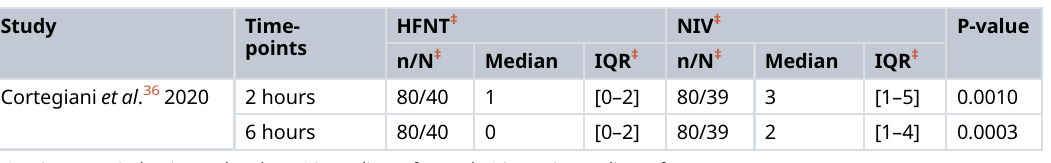
Table 7. Comfort score using 10-point numerical rating scale * (RCT comparing HFNT vs NIV).